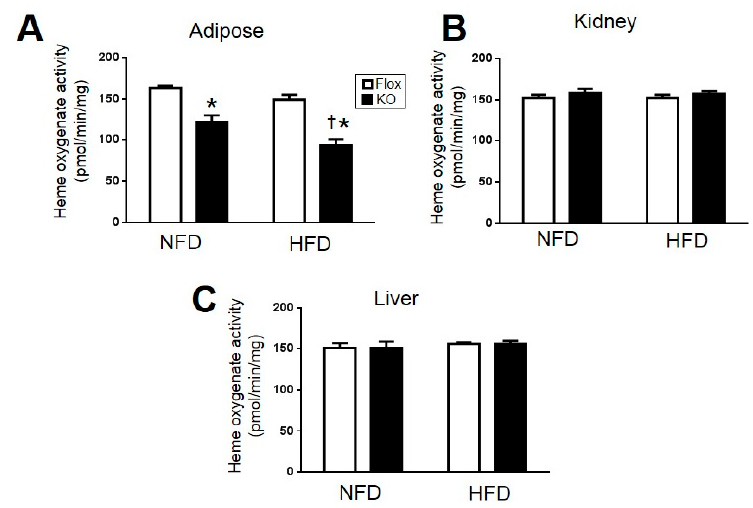
Figure 5. Heme oxygenase activity in the: ( A ) adipose tissues; ( B ) Kidney; and ( C ) Liver of Flox and KO male mice after 30 weeks of normal fat diet (NFD) and high-fat diet (HFD). * p < 0.05 compared to the corresponding value in Flox mice. † p < 0.05 compared to NFD. n = 6/group.